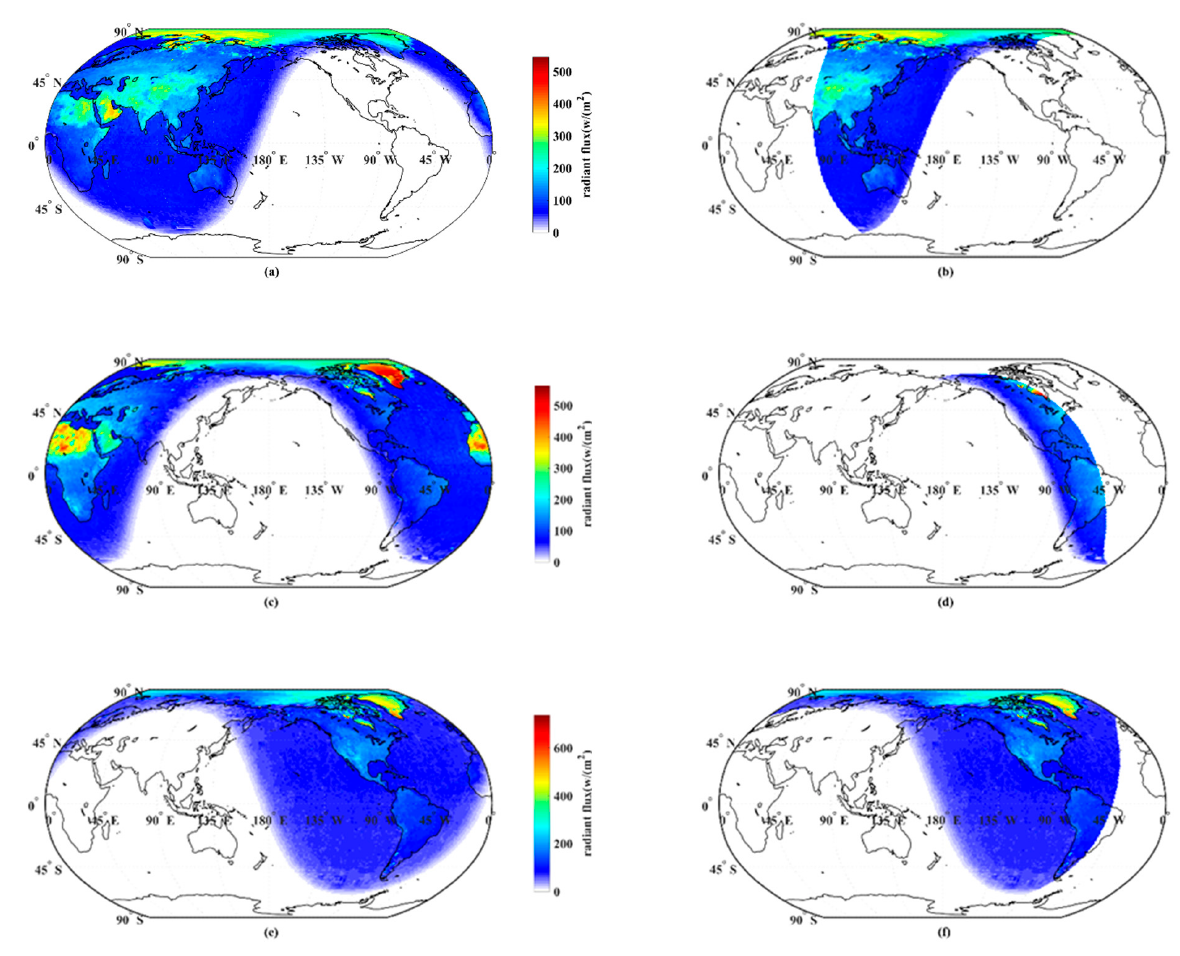
Figure 7. Hourly global TOA shortwave flux from CERES (images in the left column) and hourly TOA shortwave flux in the Moon-viewed sunlit region (images in the right column). The times of each image are: ( a , b ) 10 June 2019 06:30:14; ( c , d ) 21 June 2019 12:30:14; and ( e , f ) 30 June 2019 18:30:14.